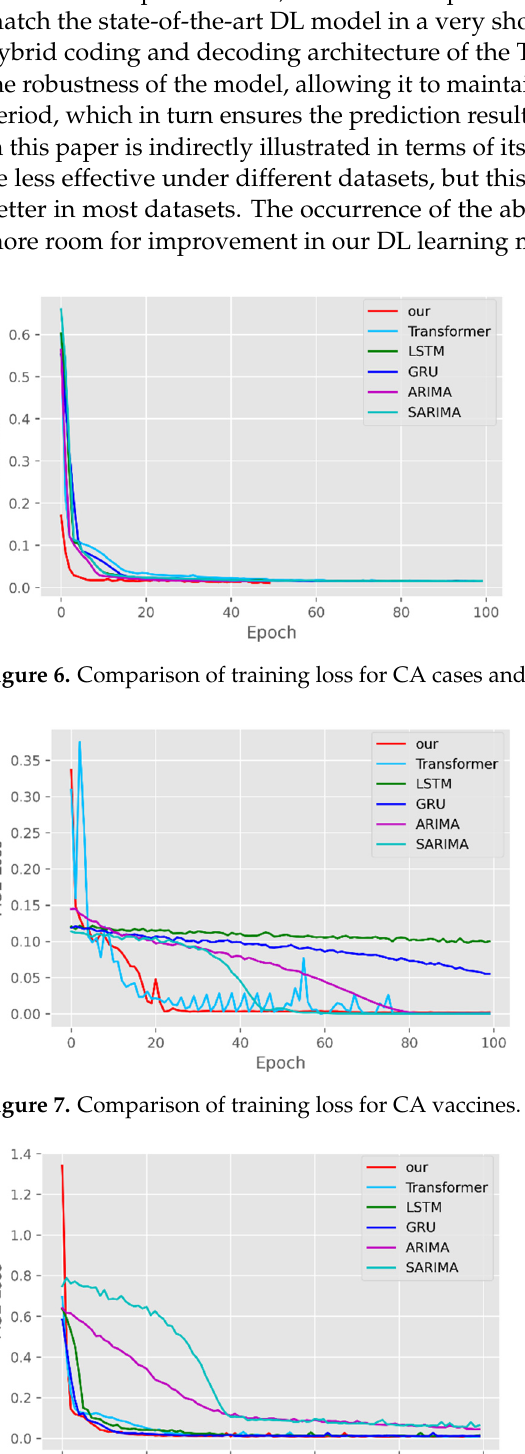
Figure 9. Comparison of training loss for NY vaccines.